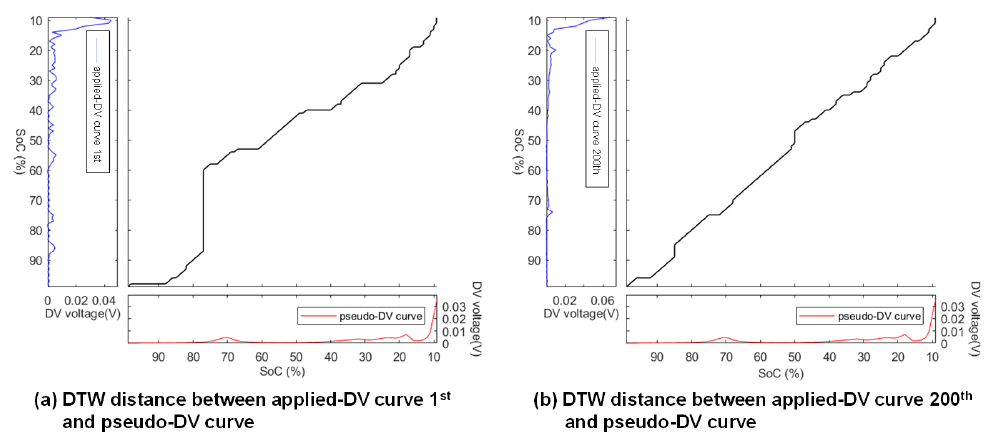
Figure 12. DTW warping paths and distances between pseudo-DV curve and applied-DV curve